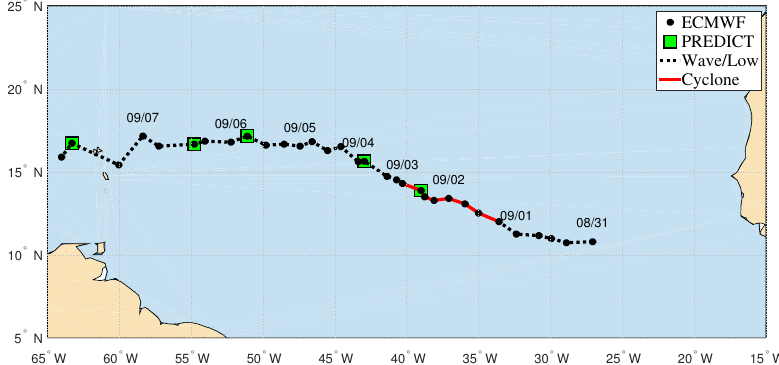
Figure 1. Track for ex-Gaston based on pouch center (black dots) as identified in the 6h, ECMWF analysis data. Green squares show approximate times of PREDICT research flights over the disturbance. The red line indicates when the National Hurricane Center designated the disturbance as at least a tropical depression. The black-dashed line indicates when the disturbance was an incipient wave or remnant low.